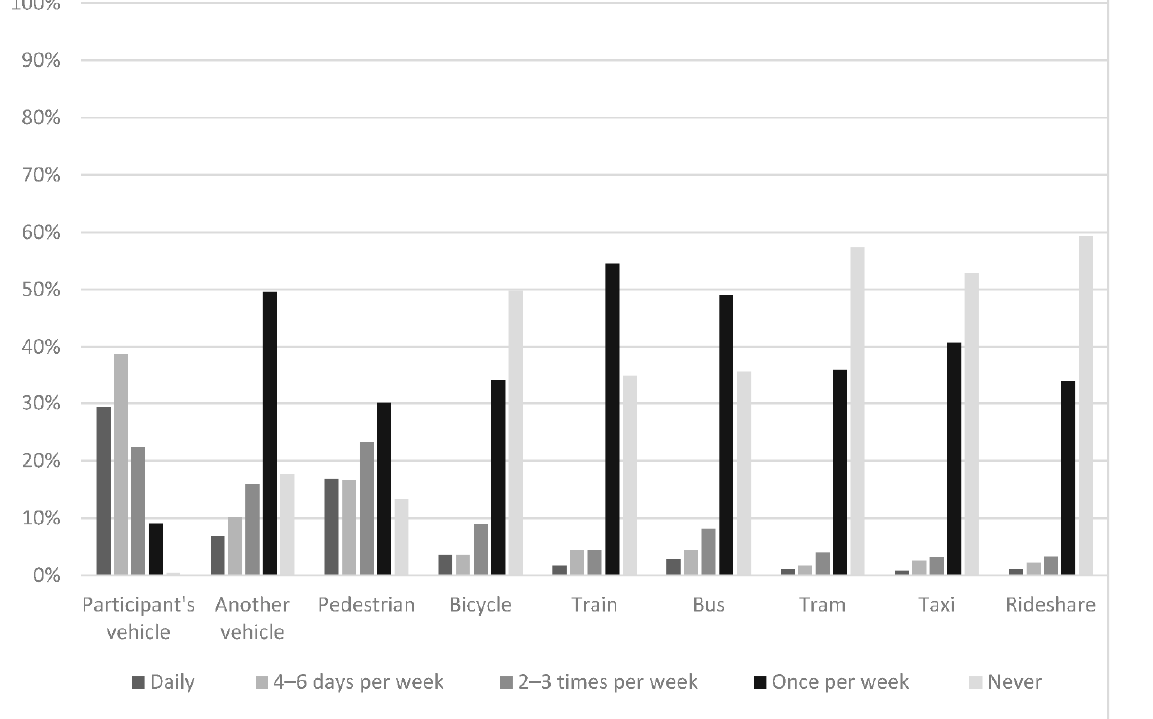
Table 4. Participants’ reasons for not travelling in a rideshare vehicle with their youngest child ( n = 375)